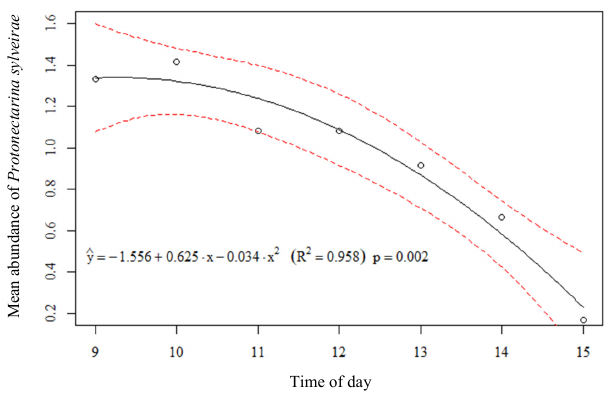
Fig 4 . Effect of time of day onaverage number of wasps of Protonectarina sylveirae (Hymenoptera: Vespidae) species foraging in kale plants ( Brassica oleracea var. acephala ) from July to November 2016 in Bambuí, MG.